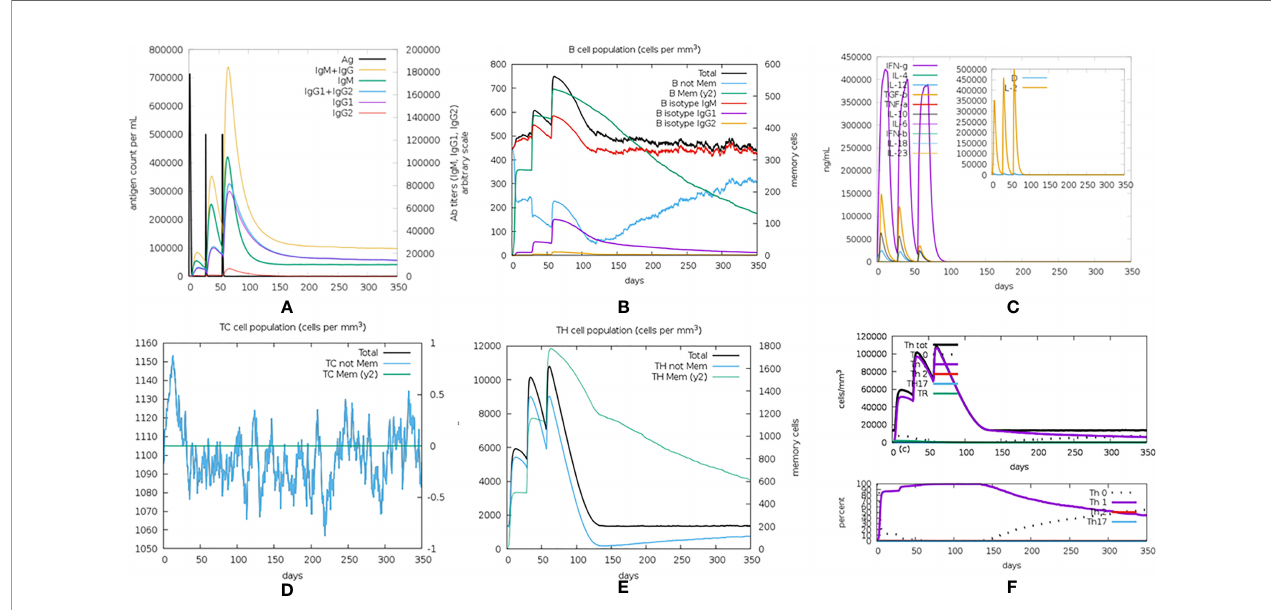
FIGURE 9 | The in silico immune simulation results. (A) Immunoglobulin levels with respect to antigen concentration. (B) Cytokine level in response to the vaccine. (C) B-cell population. (D) TC (cytotoxic) cell population. (E) TH (helper) cell population. (F) The population of different subtypes of TH